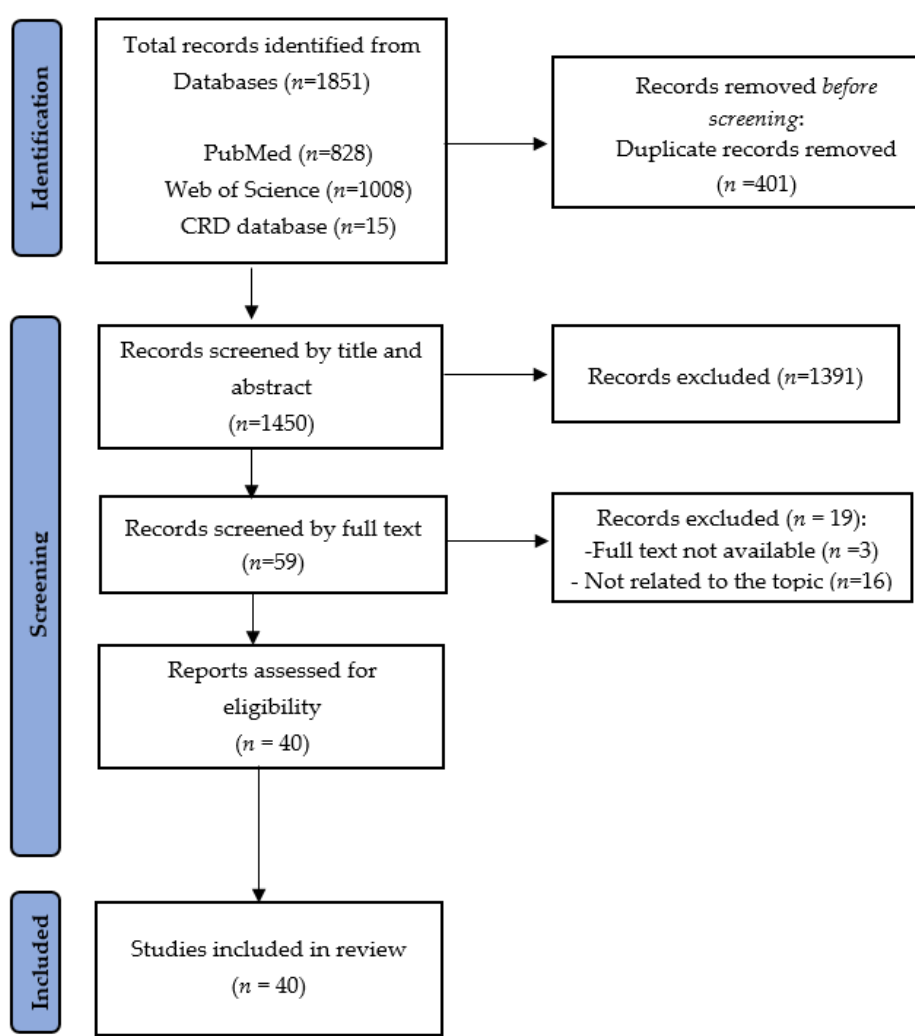
Figure 1. PRISMA statement flow diagram.